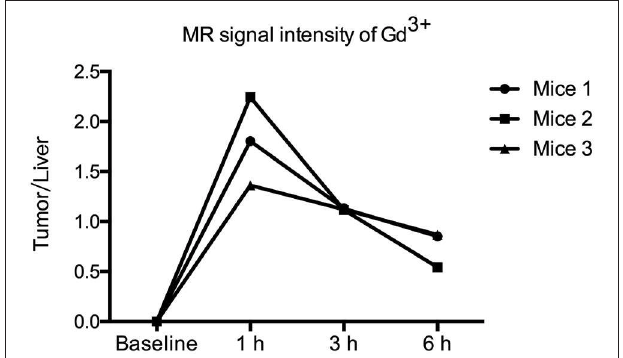
FIGURE 3 | Ratio of the MR signal intensity of Gd 3 + in the tumor and liver. The T1-weighted MR images were acquired before and 1, 3, and 6h after